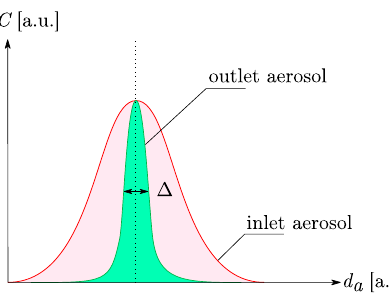
Figure 6. Illustration of the working principle of an aerosol classification by aerodynamic technique.